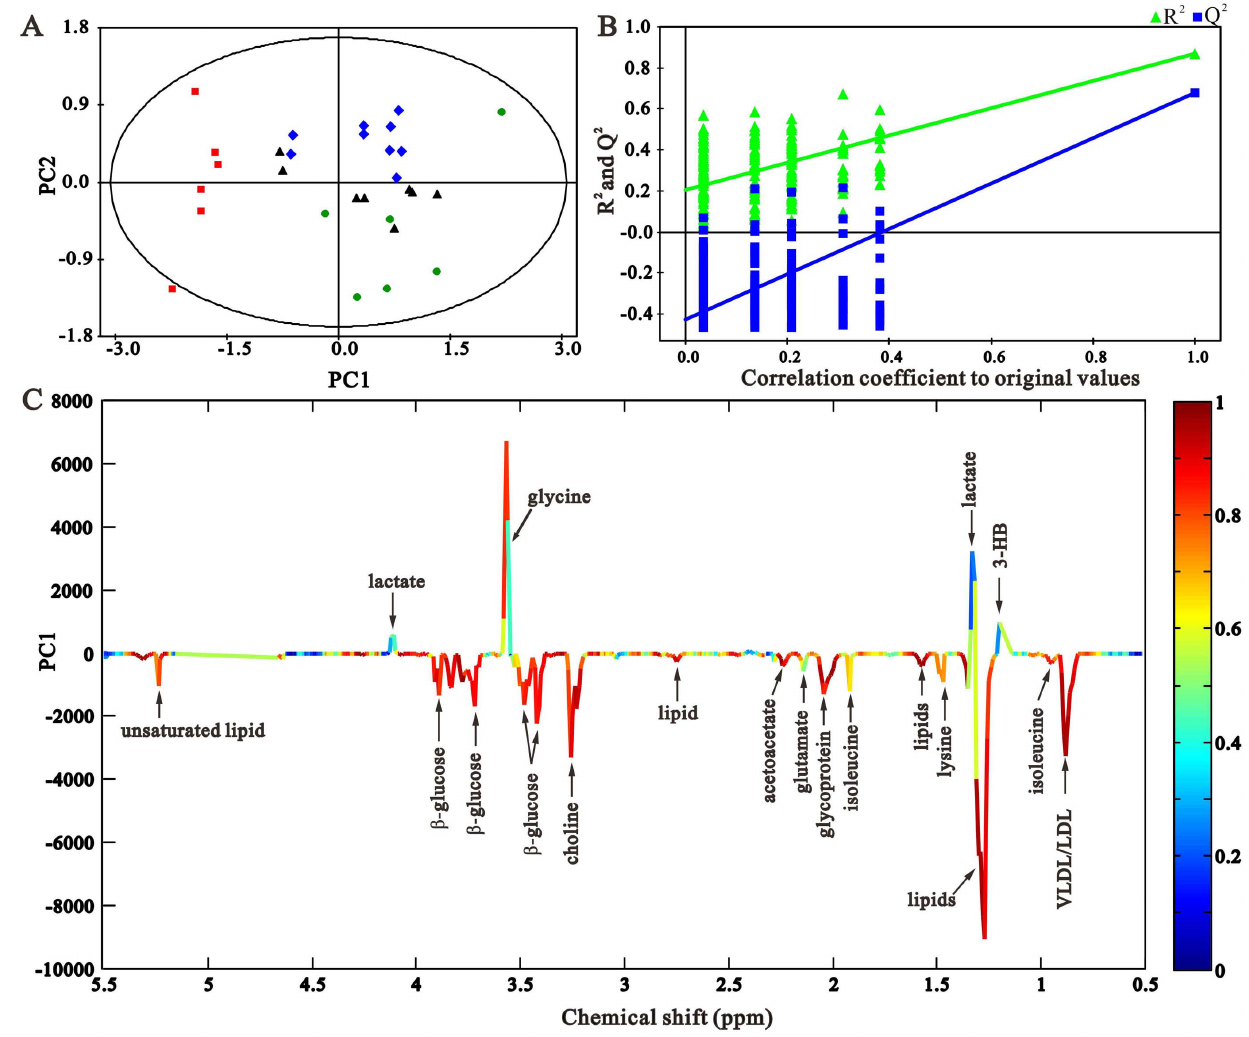
N Figure 4. PCA scores plot (A), validation plot (B) and coefficient-coded loading plot (C) based on the 1 H CPMG spectra of control ) rats on day 7. The coefficient-coded loading plot corresponding to PCA revealing the ( m ), UUO ( & ), CAO-UUO ( X ) and CAO-SO ( metabolites with large intensities responsible for the discrimination of the corresponding score plots.